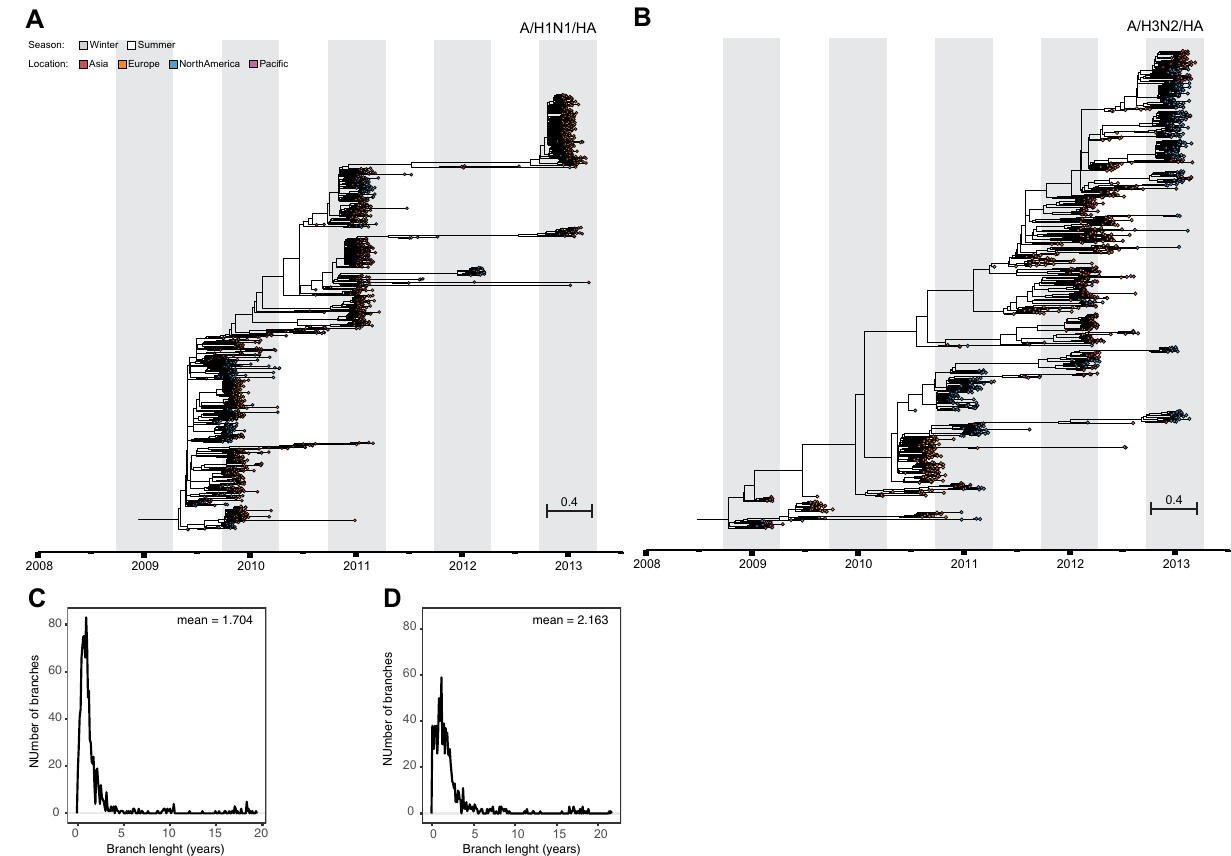
Figure 1. Spatio-temporal resolved phylogenies reveal intrinsic evolutionary influenza dynamics. Influenza hemagglutinin tree inferred by birth–death skyline phylodynamic modelling using 1078 (A/H1N1) ( A ) and 1033 (A/H3N2) ( B ) complete gene sequences. Distribution of average trunk-to-tips branch lengths of A/H1N1 ( C ) and A/H3N2 ( D ) phylogenetic